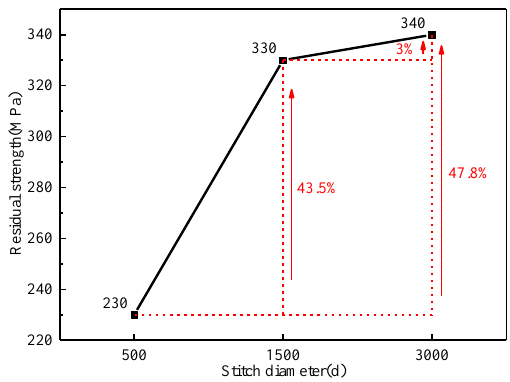
Figure 16. The effect of stitching thread thickness on residual strength under the impact of 10 J.